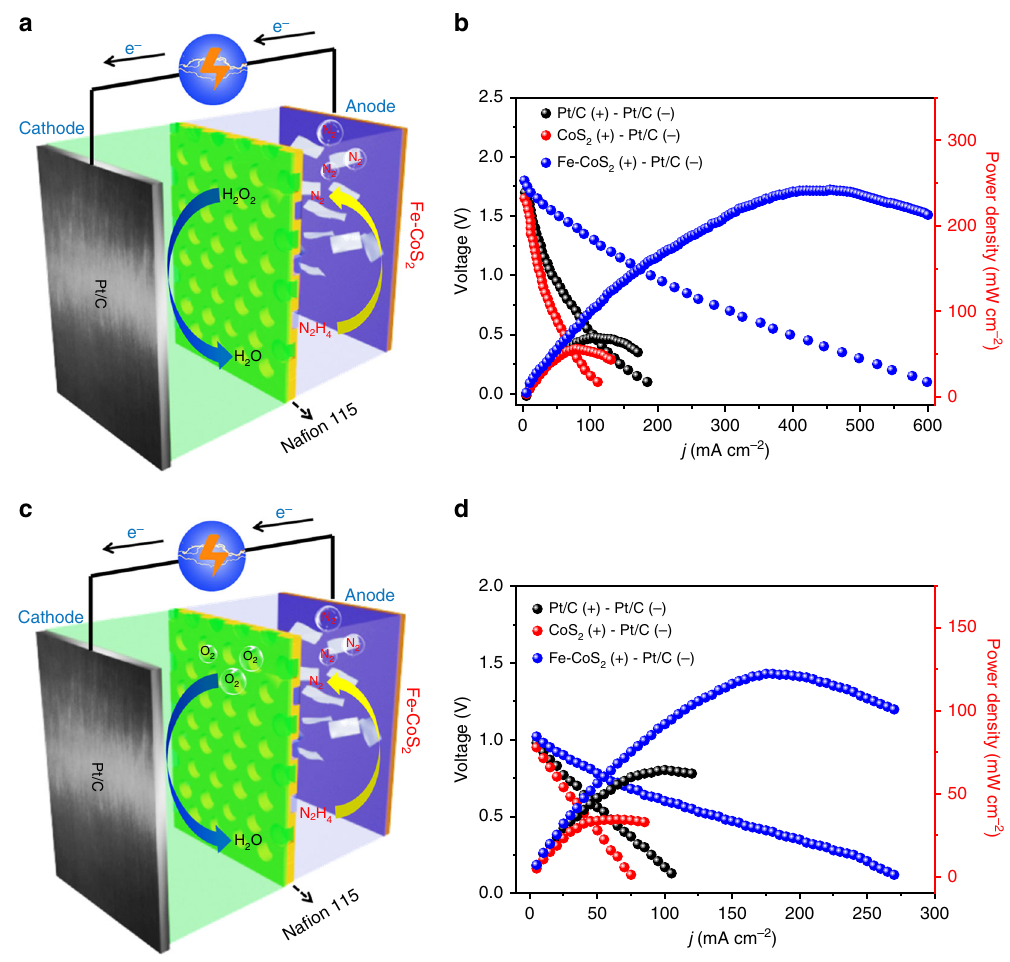
Fig. 3 Application of the Fe-CoS 2 nanosheets in DHzFCs. a Schematic image of a DHzFC assembled with the Fe-CoS 2 nanosheets as the anode and commercial 40 wt.% Pt/C as the cathode (the oxidizing agent is H 2 O 2 ). b Current density ( j ) – voltage ( V ) and current density ( j ) – power density ( P ) plots for the DHzFC in a and two other DHzFCs with the CoS 2 nanosheets and Pt/C as anodes. c , d have the same meanings as a , b but for DHzFCs with O 2 as the oxidizing agent. The optical images of the DHzFCs in a , c are in Supplementary Fig. 21. The mass loadings of the nanosheets and Pt/C in each corresponding electrode were 1.5 and 2 mg cm − 2 , respectively. The cell temperature for each DHzFC was 80 °C, which has been widely used for DHzFC evaluation